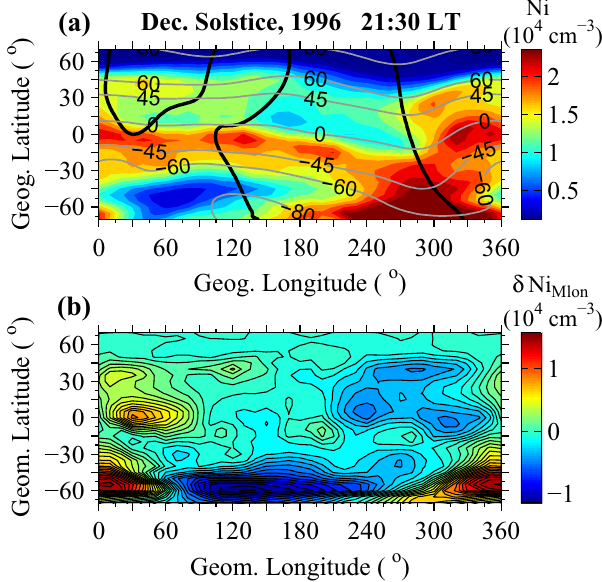
Fig. 4. (a) and (b) are same as Figures 1a and 1c, respectively, but for DMSP F12 nightside measurements around the December Solstice of